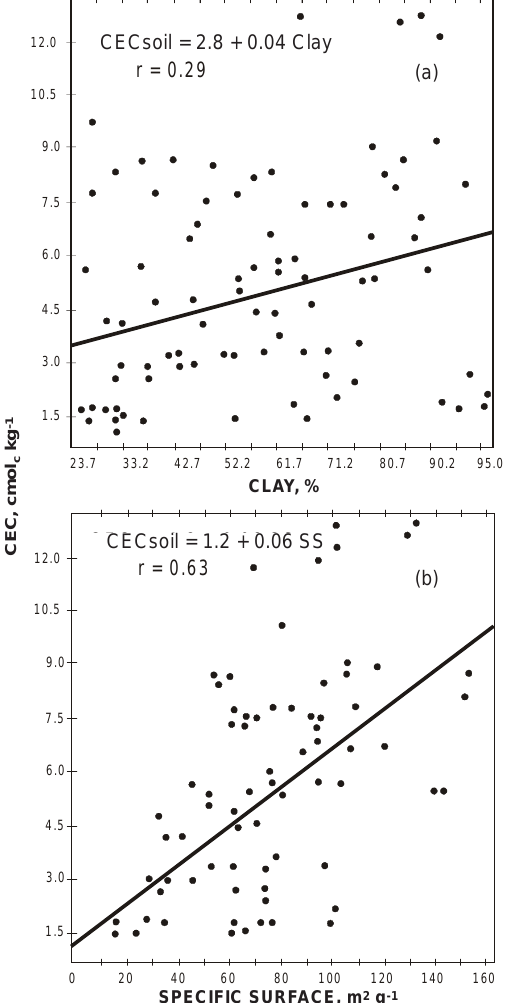
Figure 5. Correlation between: (a) CEC of Ferralic B horizons and clay content, (b) CEC of Ferralic B horizons and specific surface